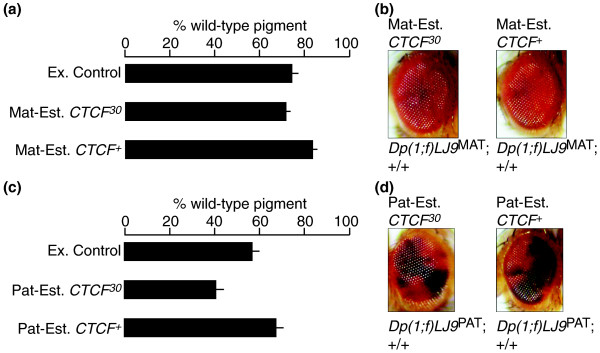
dCTCF does not affect establishment of the Dp(1;f)LJ9 imprint. All genotypes tested are y1zag53d/Dp(1;f)LJ9; +/+ but differ in parental genotype. External control progeny (Ex. Control) are generated from parents carrying Dp(1;f)LJ9 that have never been exposed to a mutant dCTCF allele. Progeny generated from a parent carrying both the imprinted Dp(1;f)LJ9 mini-X chromosome and a mutant dCTCF allele test for effects on imprint establishment (Mat or Pat-Est. CTCF30), whereas parental siblings carrying Dp(1;f)LJ9 and wild type for CTCF serve as an internal control (Mat or Pat-Est. CTCF+). (a) Maternal establishment of the Dp(1;f)LJ9 imprint is not affected by CTCF30. No significant change in red pigment levels was detected between external control progeny (Ex. Control; n = 23), mothers carrying Dp(1;f)LJ9MAT, and CTCF30 (Mat-Est. CTCF30; n = 10), and mothers carrying Dp(1;f)LJ9MAT and CTCF+ (Mat-Est. CTCF+; n = 10). (b) No phenotypic difference is present between progeny generated from Dp(1;f)LJ9 carrying mothers, either mutant (Mat-Est. CTCF30) or wild type (Mat-Est. CTCF+), for CTCF. (c) Paternal establishment of the Dp(1;f)LJ9 imprint is not affected by CTCF30. No significant change in red pigment levels was detected between external control (Ex. Control; n = 44), fathers carrying Dp(1;f)LJ9PAT and CTCF30 (Pat-Est. CTCF30; n = 18), and fathers carrying Dp(1;f)LJ9PAT and CTCF+ (Pat-Est. CTCF+; n = 29). (d) No phenotypic difference is present between progeny generated from Dp(1;f)LJ9 carrying fathers, either mutant (Pat-Est. CTCF30) or wild type (Pat-Est. CTCF+) for dCTCF.